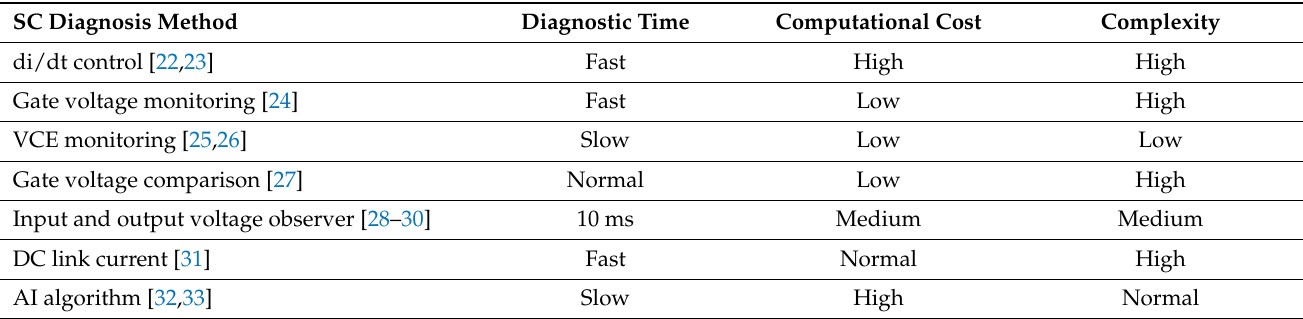
Table 1. Overview of the fault diagnosis methods for